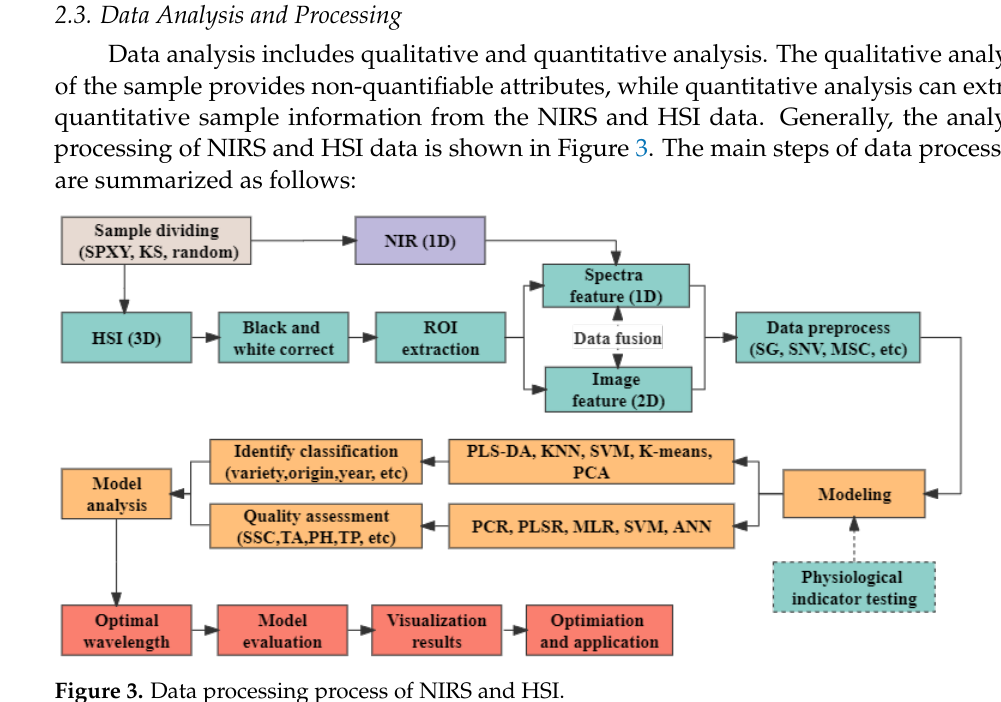
Figure 3. Data processing process of NIRS and